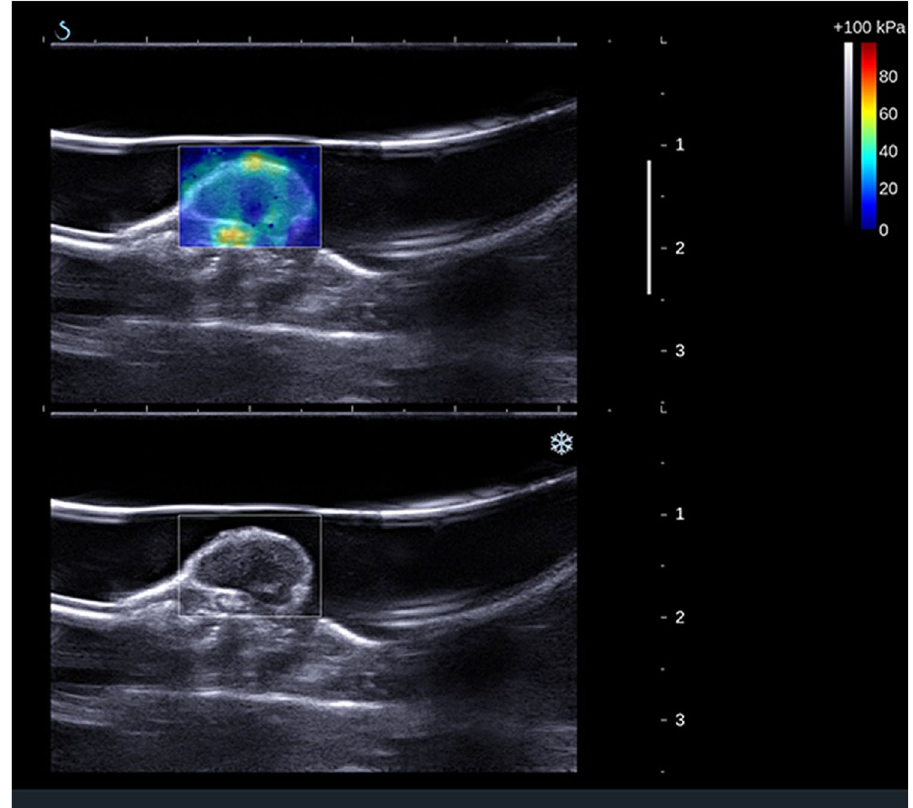
Figure 2. Image acquisition. B-mode image in sagittal plane of the tumour located on the flank of the mouse with (top panel) and without (bottom panel) the elasticity box. The scale on the right represents depth (cm) and the white line indicates the focus position. The colourmap indicates elastic (Young’s) modulus values in kPa. White line above the tumour is a nylon pocket.